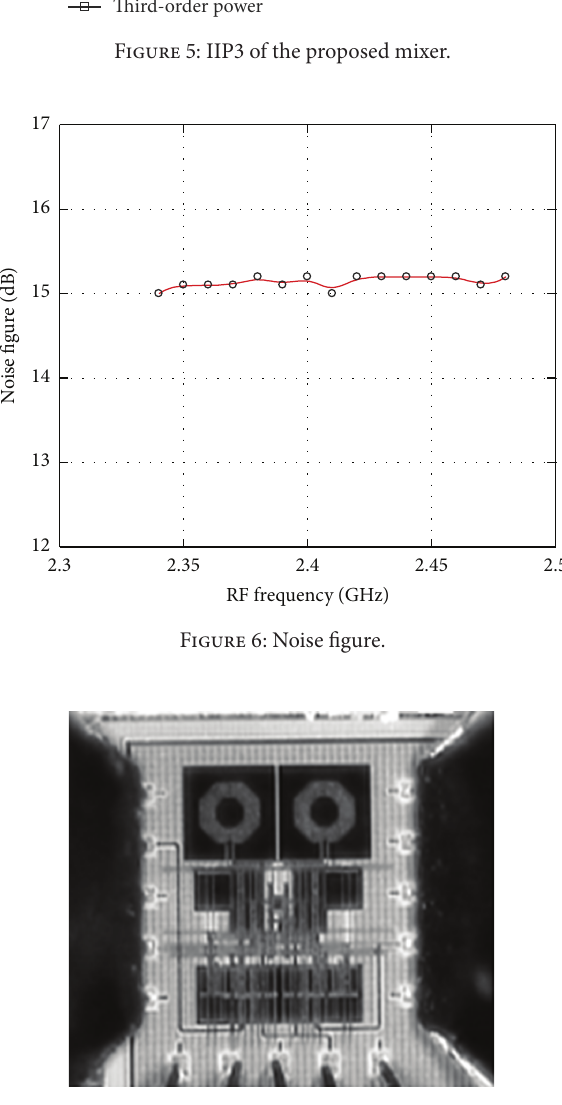
Figure 7: A chip micrograph of the proposed mixer.